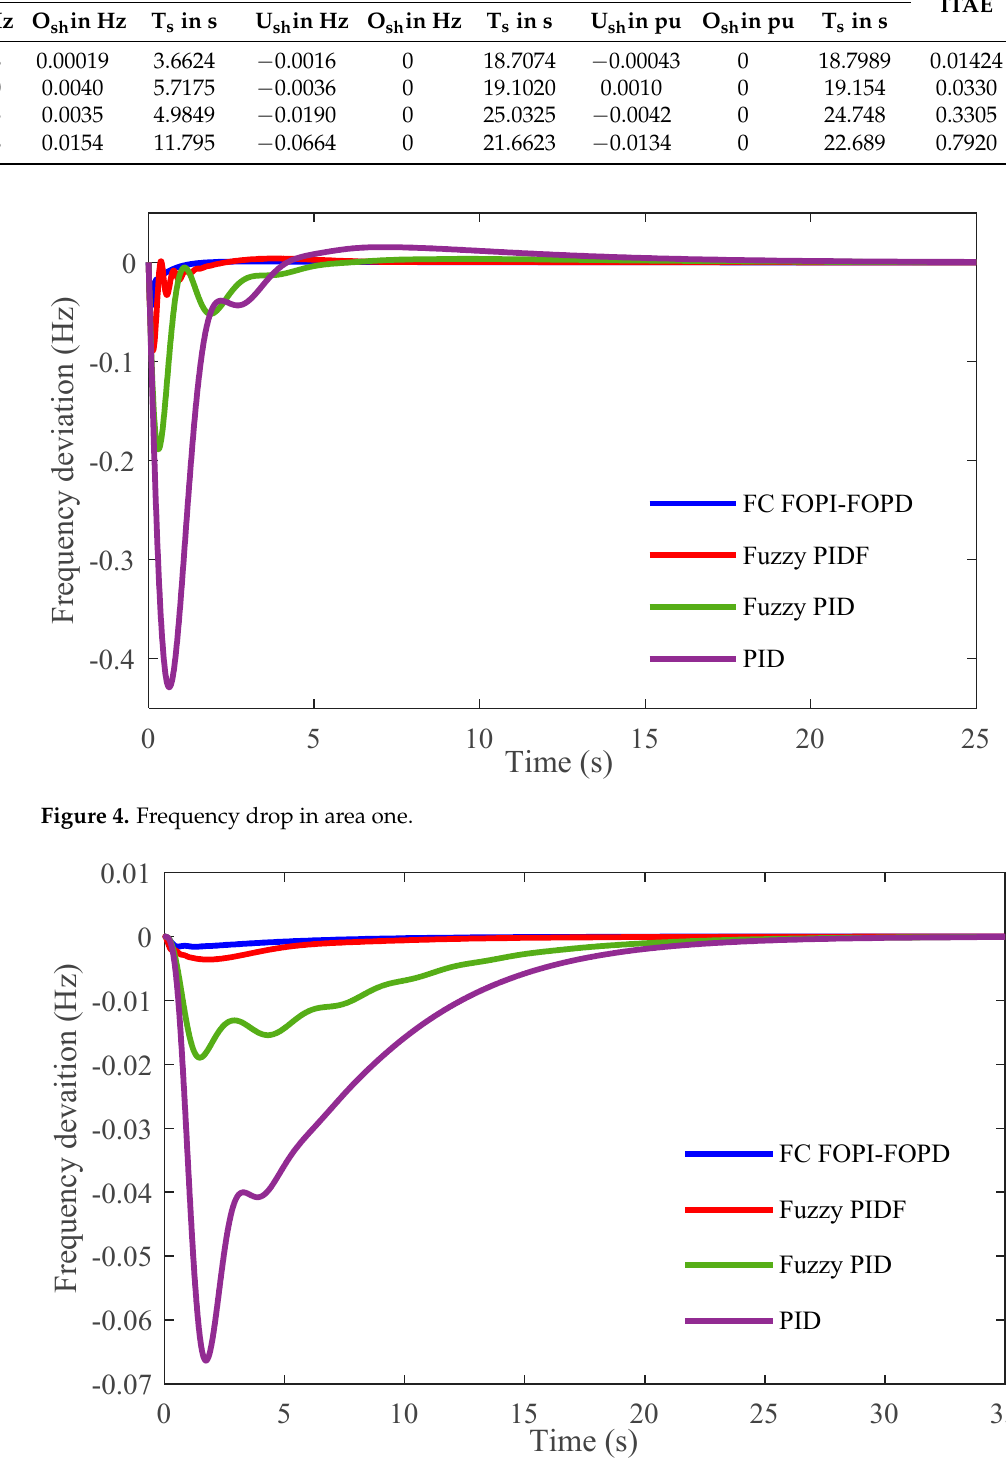
Figure 5. Frequency drop in area two.